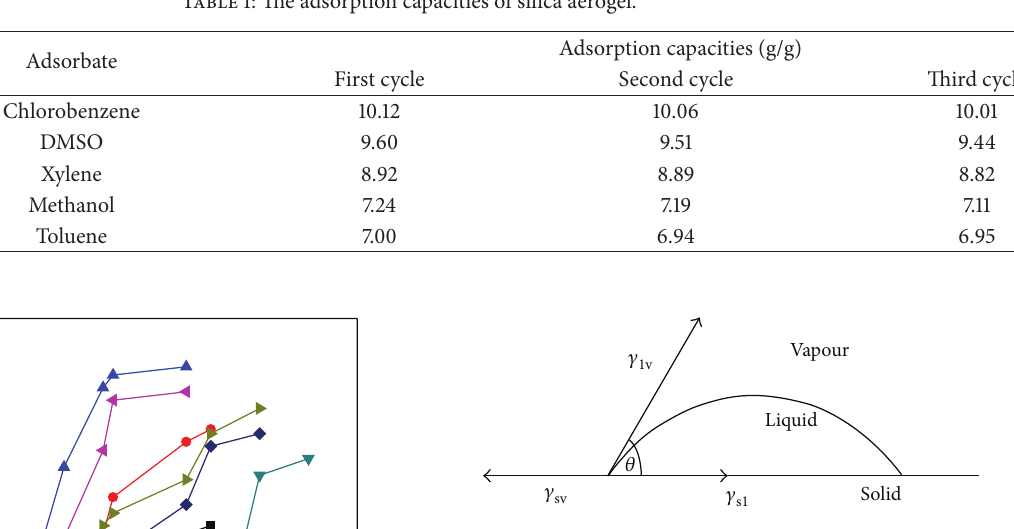
Figure 10: Balance of forces at the contact line solid-liquid-vapor